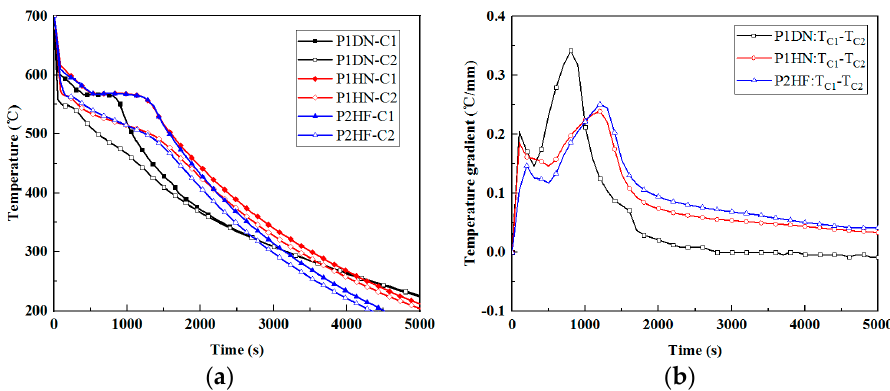
Figure 12. ( a ) Cooling curves of points C1 and C2 of the castings, ( b ) Temperature gradient between C1 and C2 of the castings.